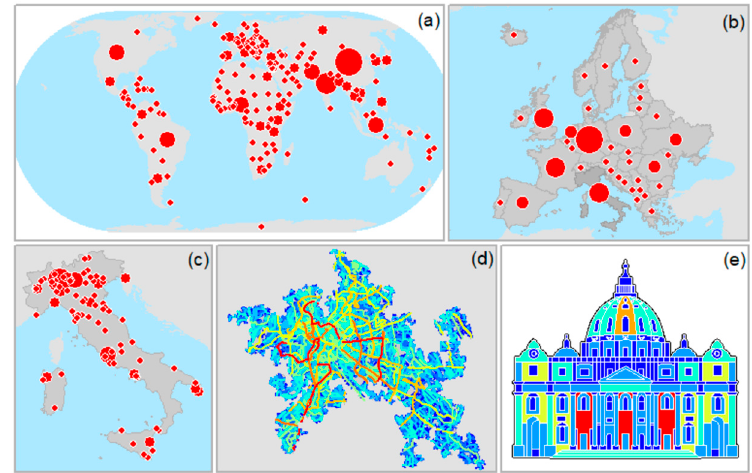
Figure 5. (Color online) The Earth’s surface as a coherent whole, being a living structure. Note: The living structure—scaling hierarchy of “far more smalls than larges”—recurs at di ff erent levels of scale of the Earth’s surface from ( a ) the global scale, ( b ) the European scale, ( c ) the country scale of Italy, ( d ) the city scale of Rome, and to ( e ) the building scale of St. Peter’s Basilica. For panels ( d ) and ( e ), the blue indicates the least-connected or smallest, red indicates the most-connected or the largest, and other colors are between the smallest and largest.